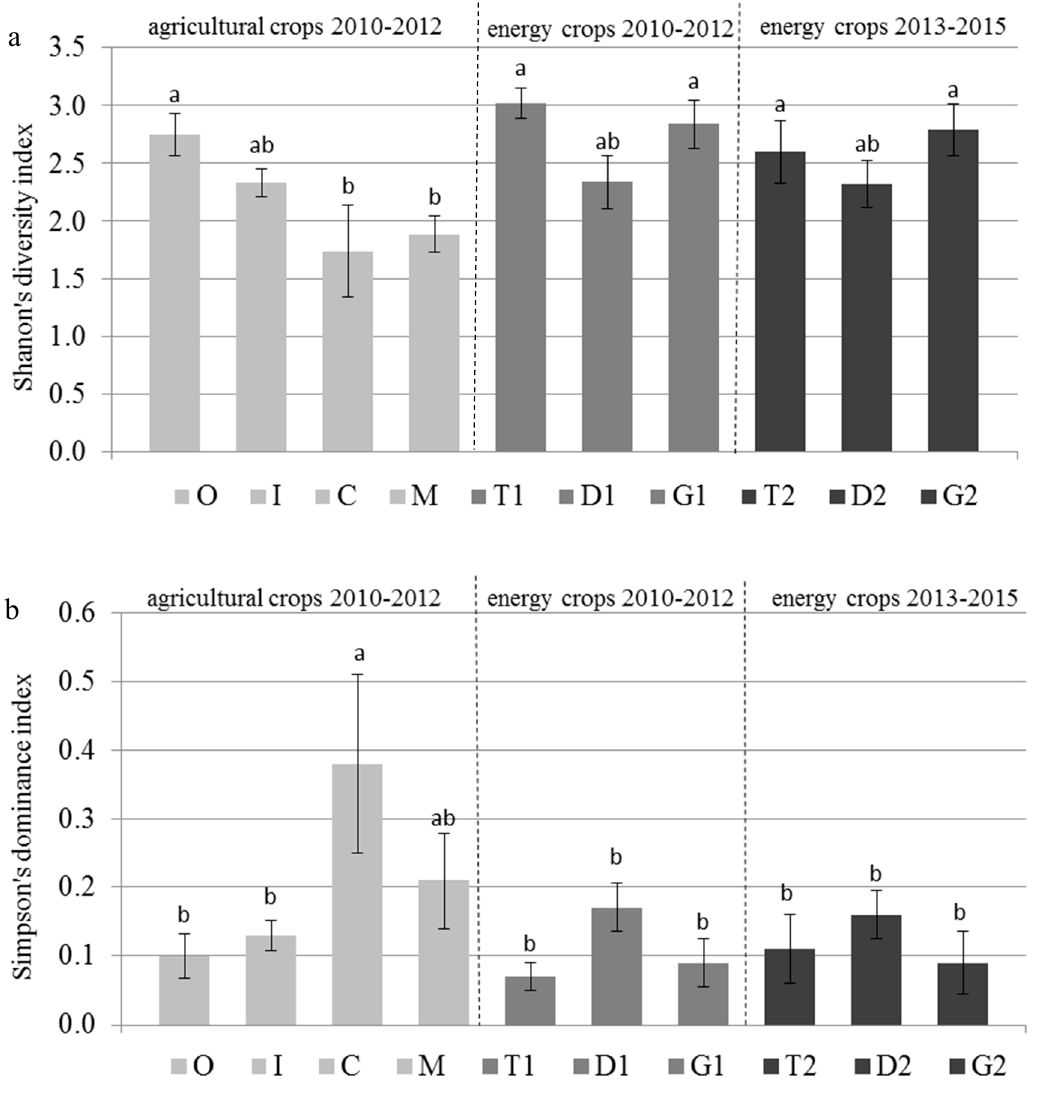
Figure7. Shannon’sdiversityindex( a )andSimpson’sdominanceindex( b )( ± SD)forweedcommunities Figure 7. Shannon’s diversity index ( a ) and Simpson’s dominance index ( b ) (±SD) for weed under di ff erent farming systems and in groups of plants cultivated for energy purposes. The letters communities under different farming systems and in groups of plants cultivated for energy purposes. give the results of the nonparametric Kruskal-Wallis test ( p ≤ 0.05). The same letters indicate that The letters give the results of the nonparametric Kruskal ‒ Wallis test ( p ≤ 0.05). The same letters the objects are not significantly di ff erent. Explanations of symbols: O—Organic, indicate that the objects are not significantly different. Explanations of symbols: O—Organic, I—